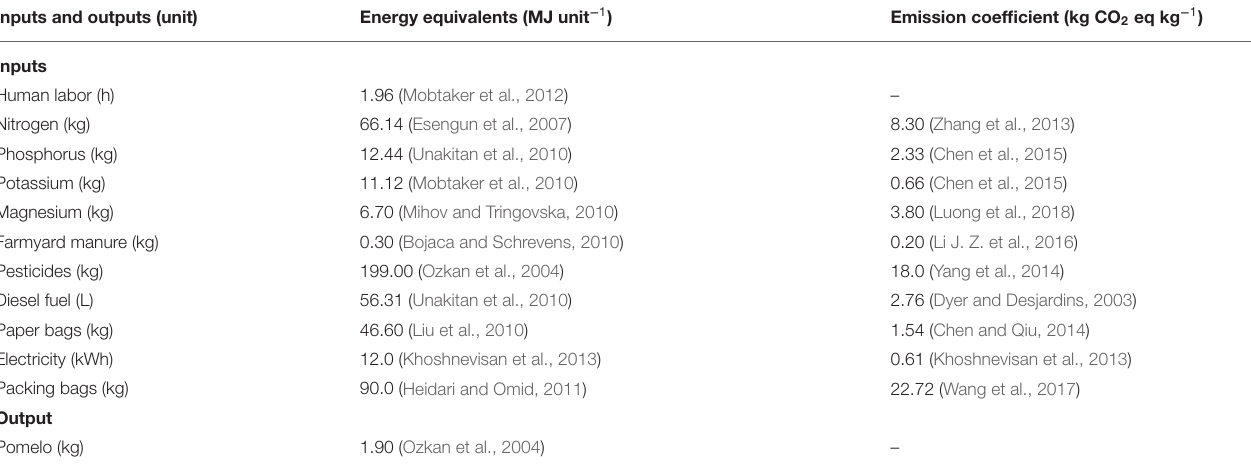
TABLE 1 | Energy equivalents and greenhouse gas (GHG) emission coefficients in agricultural production. Inputs and outputs (unit)